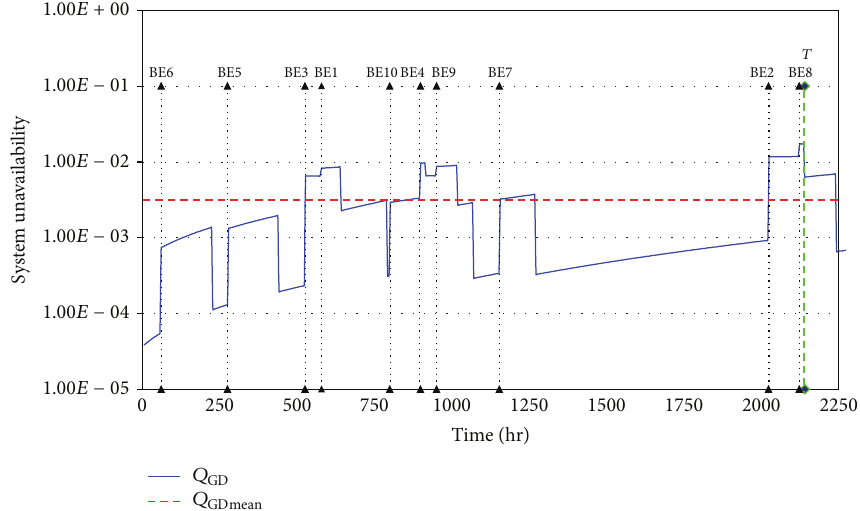
Figure 5: System unavailability of the AFW system over time for case scenario 2, no constraints considered.